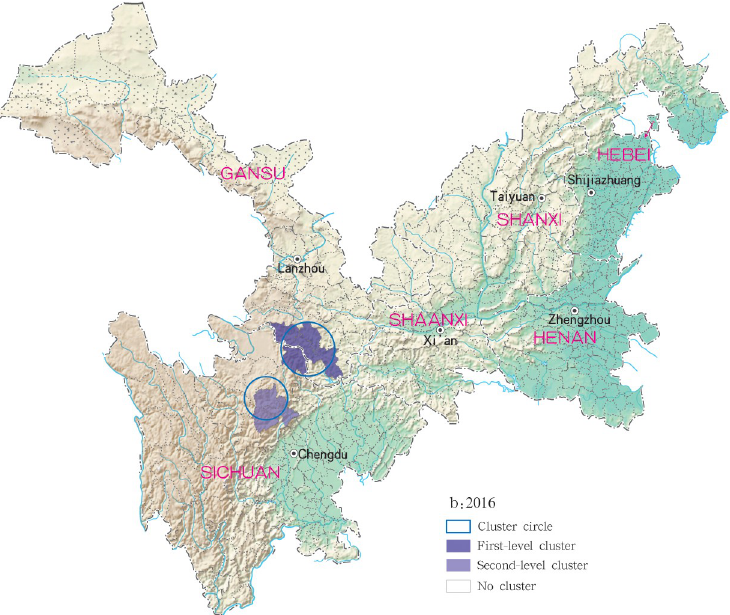
Fig 12. Spatio-temporal clustering analysis of mountain-type zoonotic visceral leishmaniasis incidence in 6 provinces, China in 2016.